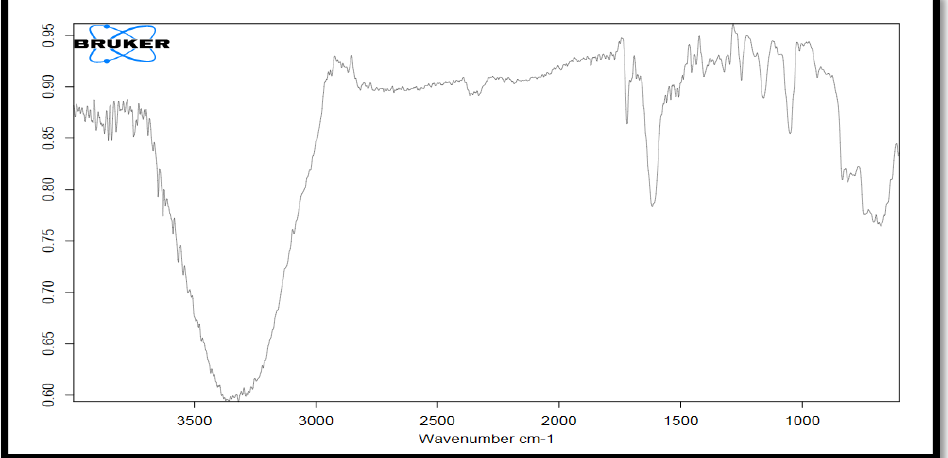
Fig. 6. FTIR spectra for DMA-co-MMA-co-TRIS.